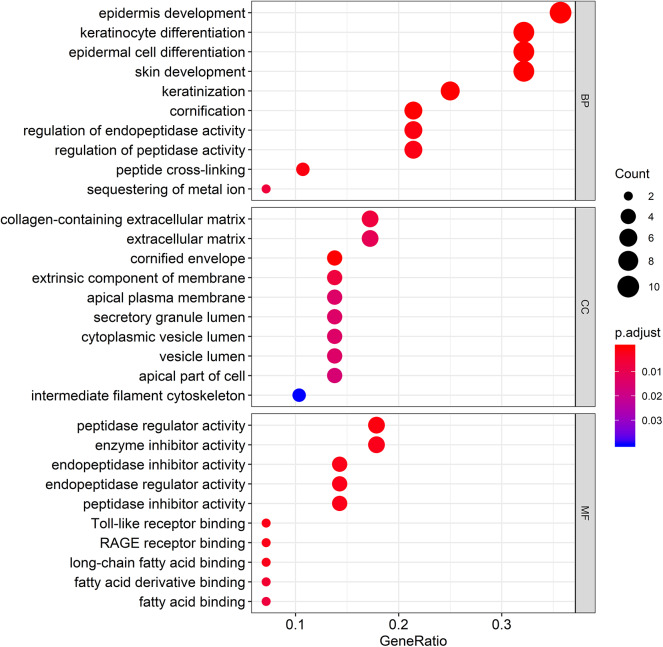
Gene Ontology (GO) enrichment analysis for the genes in the brown module. The color represents the adjusted p-values (BH), and the size of the spots represents the gene number.